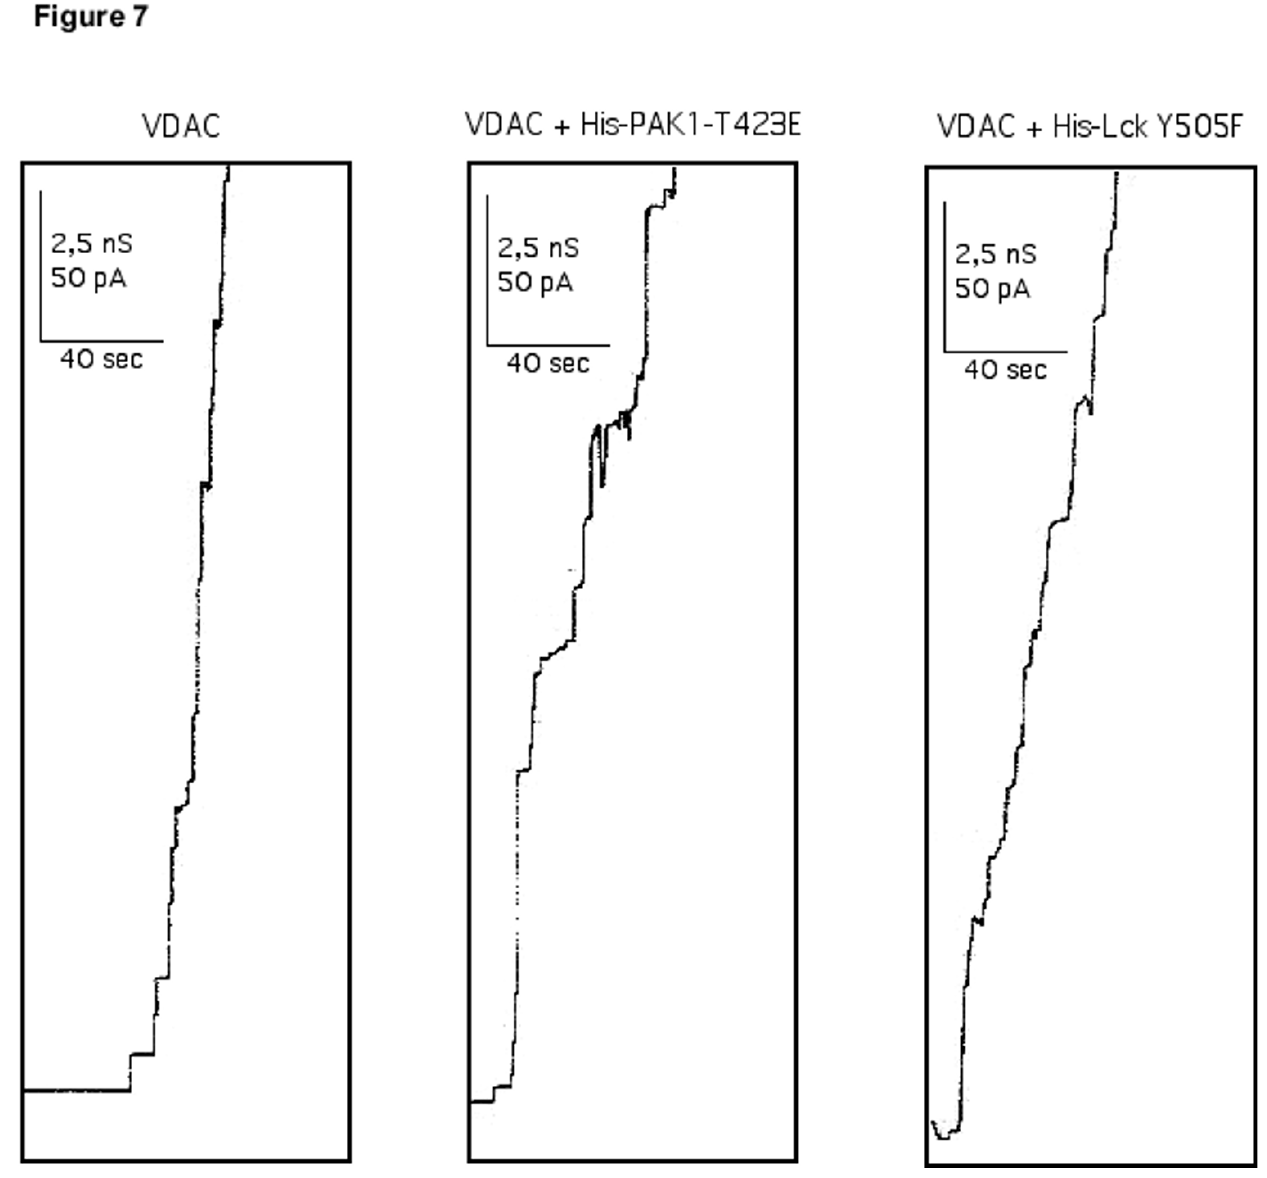
Figure 7 VDAC function is unaffected by active PAK1 or Lck kinase . As a negative control VDAC was pre-incubated with active His-PAK1- T423E or active His-LckY505F recombinant proteins (C). The aqueous phase contained 0.3 M KCl and the applied membrane potential was 20